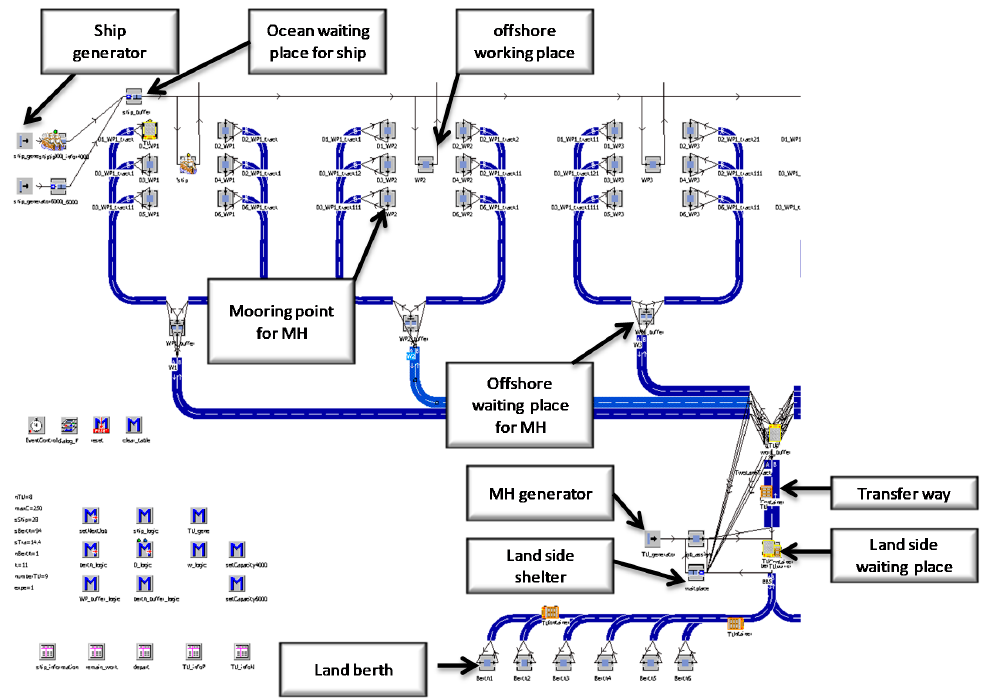
Figure 3. Simulation layout.